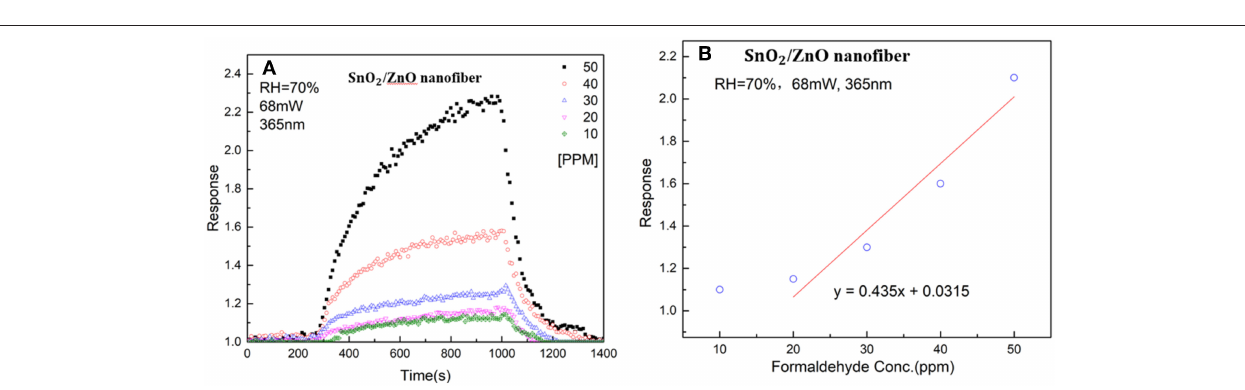
FIGURE 6 | (A) Response of the SnO 2 /ZnO heterojunction based gas sensor to different concentrations of formaldehyde from 10 ppm to 50 ppm with the light illumination at a wavelength of 365nm and the humidity of RH = 70% in ambient and (B) the correlation curve of the sensor response to formaldehyde vapor